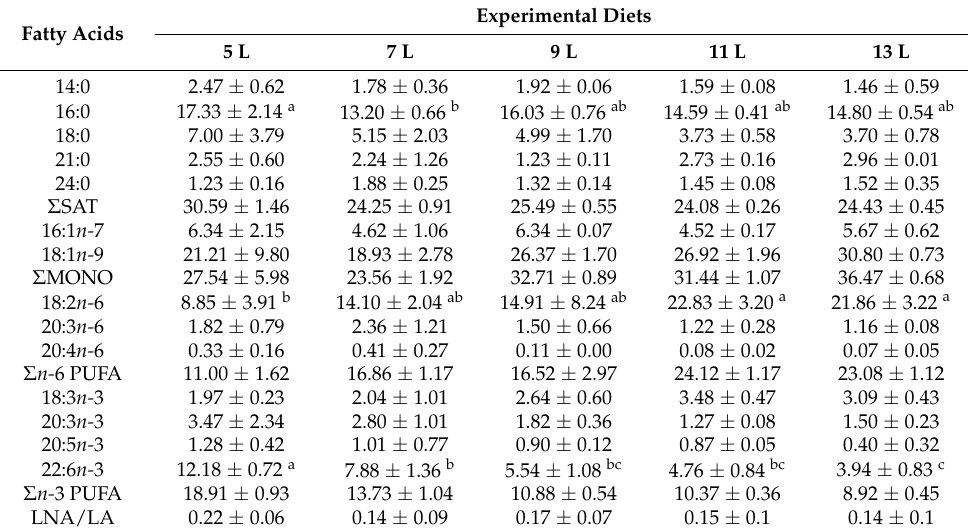
Table 6. Fatty acid composition (%) of gonad from Onychostoma macrolepis fed diets differing in their crude lipid